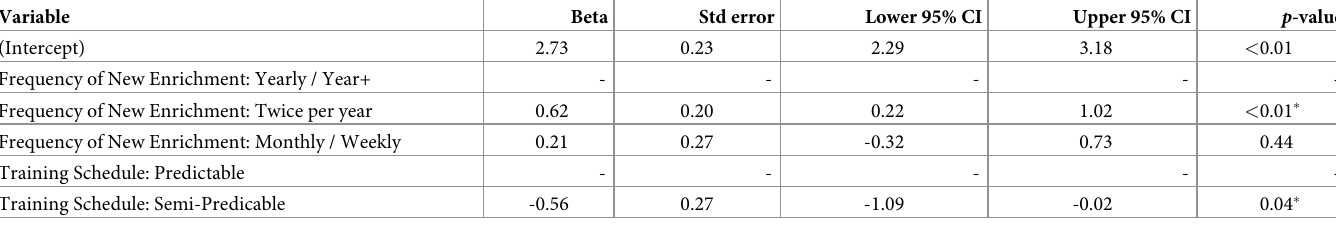
Table 6. Results for the full multivariate model examining average distance traveled per